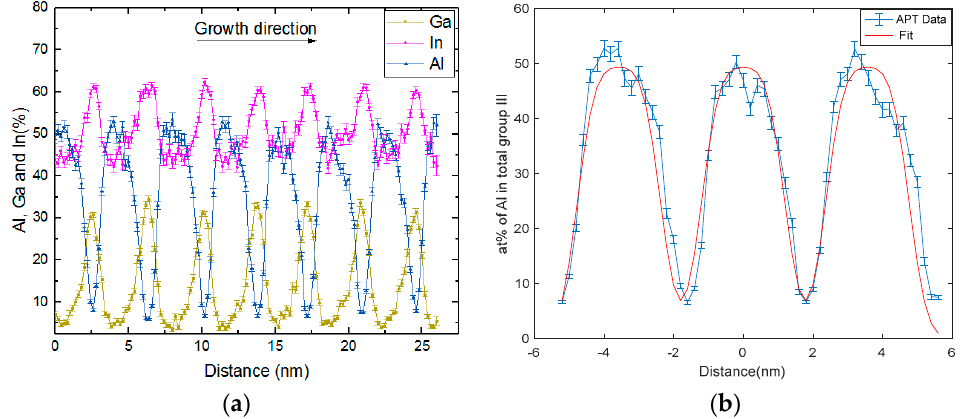
Figure 4. ( a ) Proxigram concentration profiles for the group III elements perpendicular to the interface in the thick-motif SL. Error bars represent the count of the statistical precision of the atom probe data; ( b ) Measured Al concentration profile, together with a best-fit semi-infinite solid solution to Fick’s second law of diffusion applied to the InGaAs–InAlAs interface.